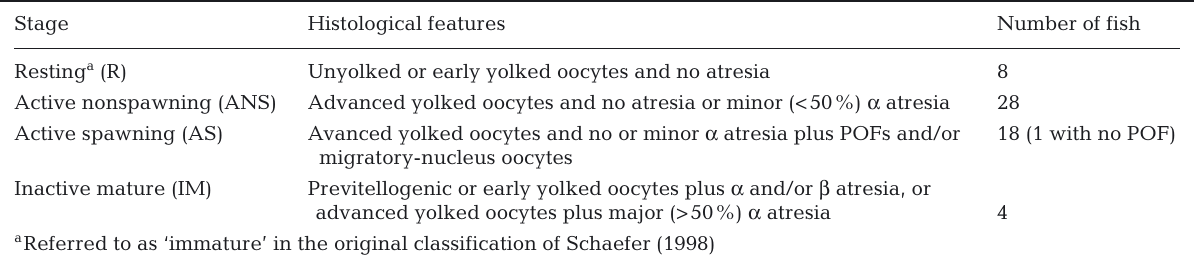
Table 1. Classification of Atlantic bluefin tuna Thunnus thynnus females in 4 different reproductive stages based on histological features according to Schaefer (1998). POF: postovulatory